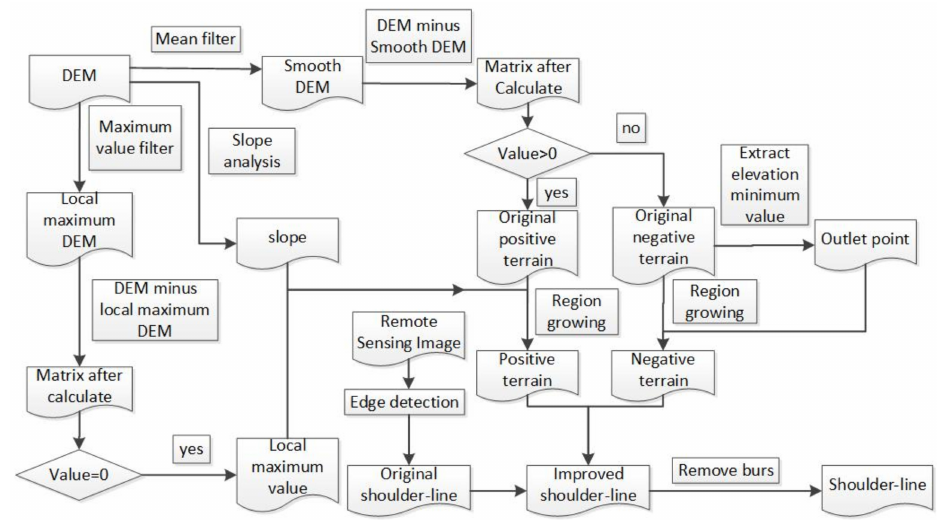
Figure 7. The complete process of our